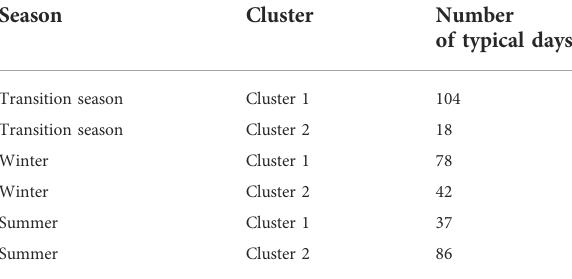
TABLE 1 Typical day